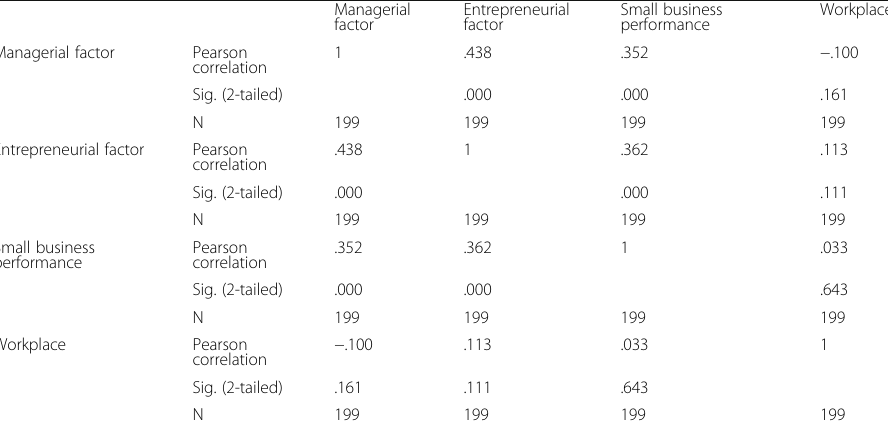
Table 2 Correlation analysis between independent variables and the dependent variable Managerial